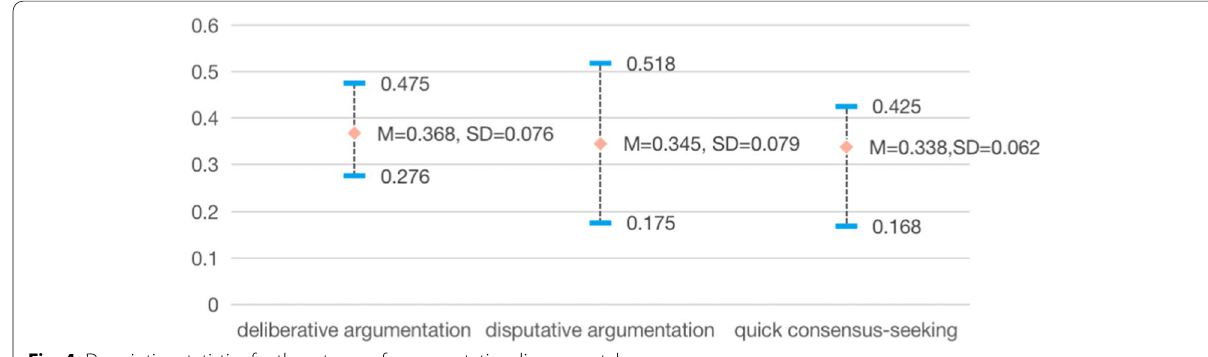
Fig. 4 Descriptive statistics for three types of argumentative discourse styles